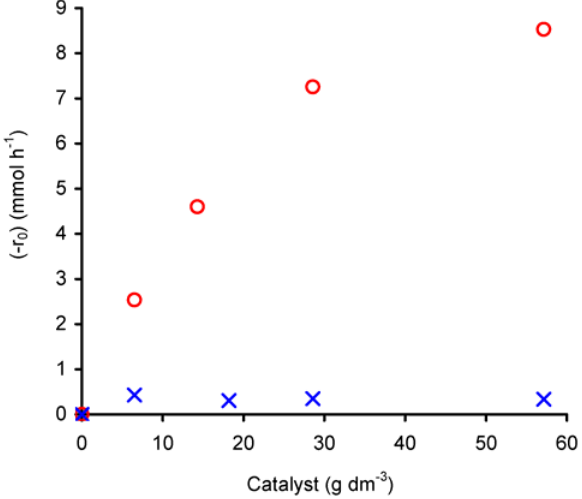
Figure 6. Dependence of the initial rate of cyclooctene epoxidation (with t- BuOOH in decane), catalysed by compounds 1 ( ○ ) or 2 ( × ), as a function of the initial amount of charged